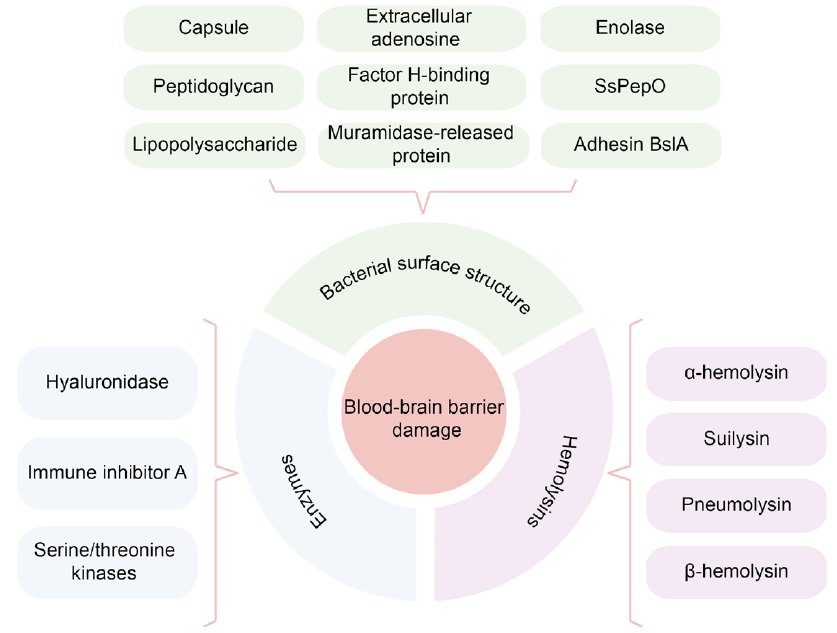
Figure 2. A brief summary of bacterial virulence factors that affecting the BBB permeability.